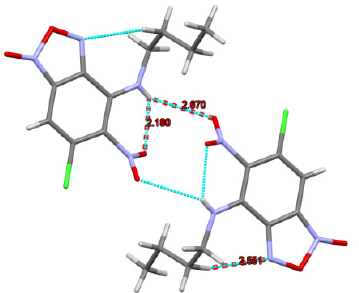
Figure 10. A packing of molecules in crystal of compound 4a .